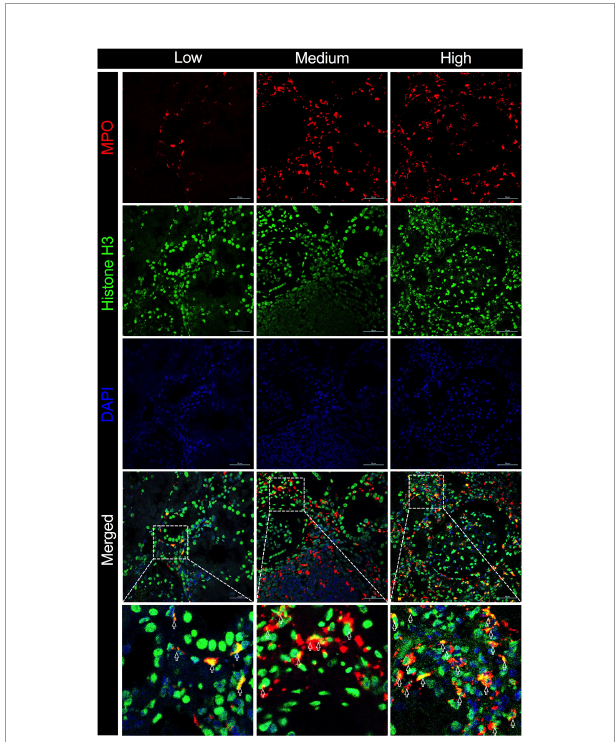
FIGURE 6 | Macrophage extracellular traps (METs) in allograft biopsies of kidney transplant recipients associated with elevation in plasma ddcfDNA levels. Immuno fl uorescence staining with anti-MPO (in red) and anti-Histone H3 (in green) antibodies for METs in allograft biopsy. Representative images of METs in low (ddcfDNA 0.38%, TCMR IB), medium (ddcfDNA 0.87%, TCMR IIA), and high (ddcfDNA 9.99%, ABMR) plasma ddcfDNA-level cohorts. Boxed areas in the merged images present the regions of interest showing double positive cells in light yellow. Arrows are typical examples for METs. Scale bar: 50 m